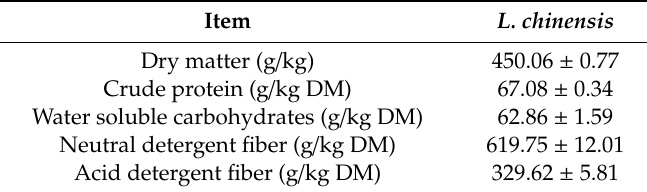
Table 1. Chemical composition of L. chinensis material before ensiling ( ±